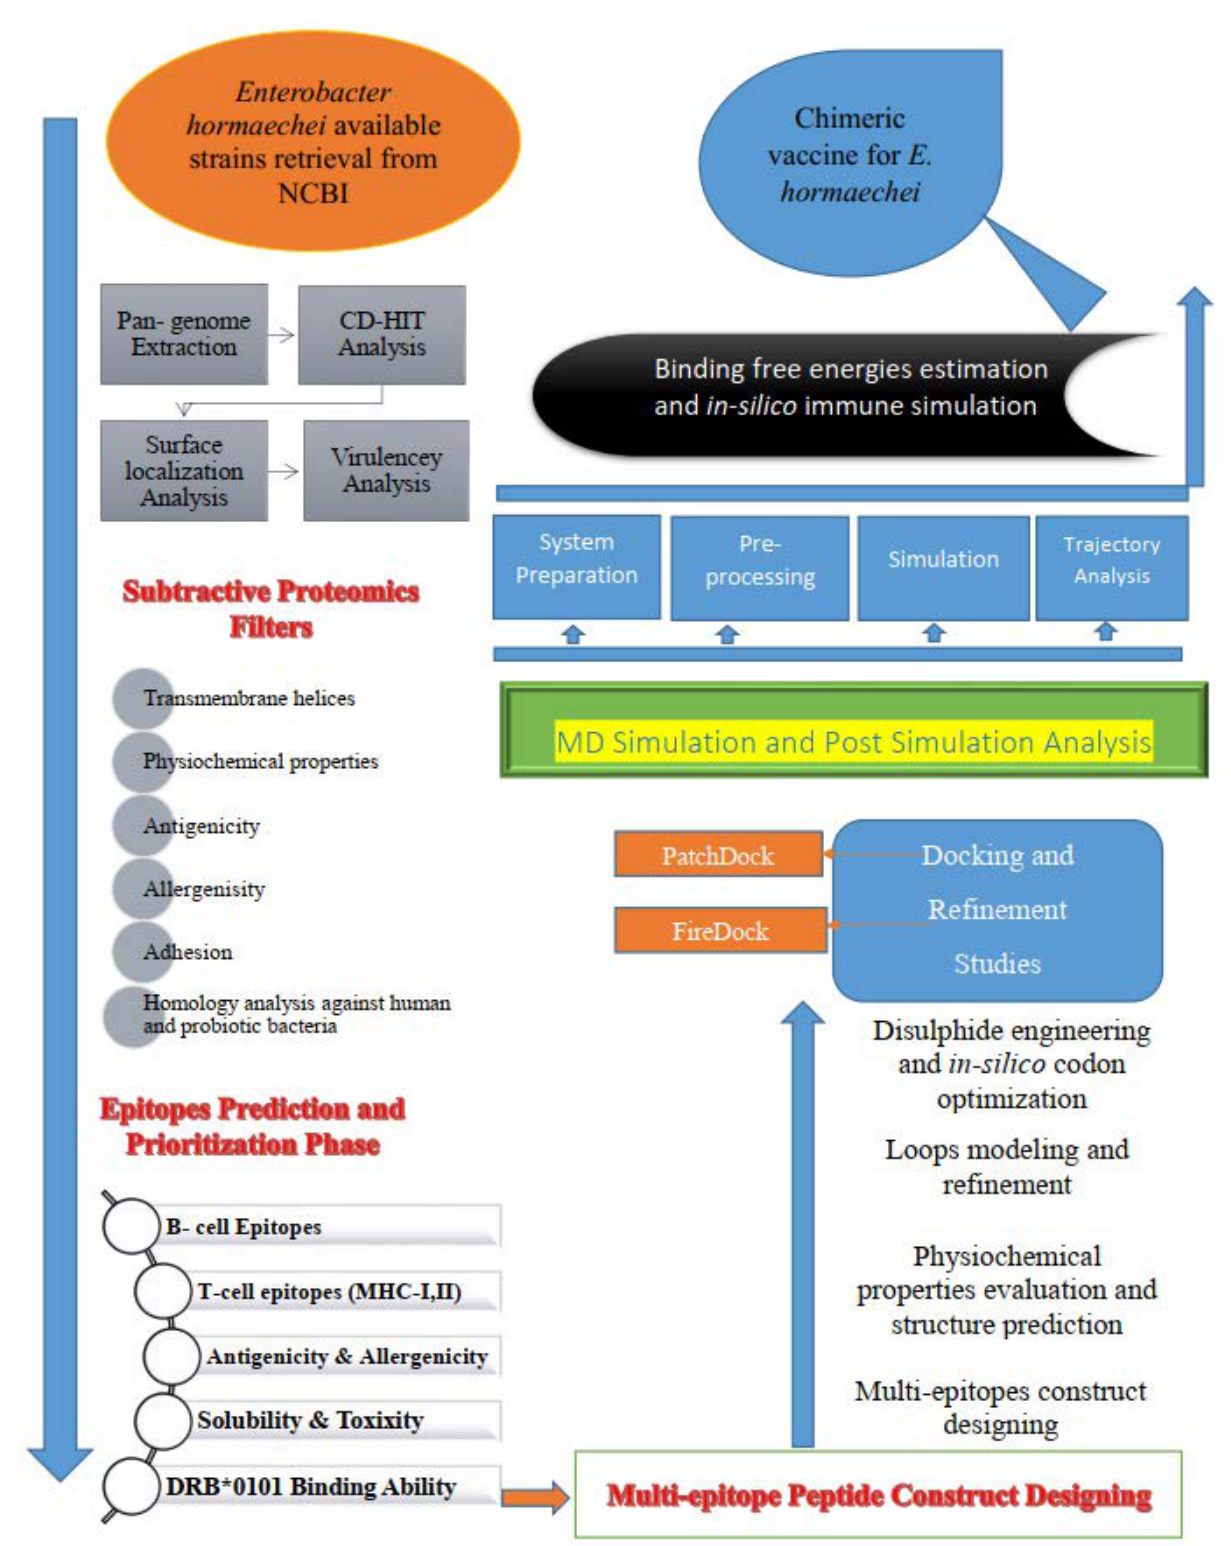
Figure 1. In silico approach used for the design of multi-epitope vaccine against E. hormaechei